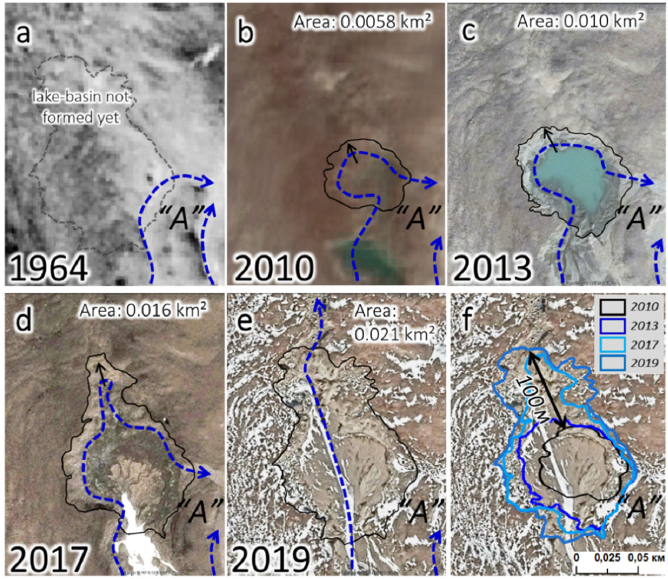
Figure 7. The Toguz-Bulak lake basin, 1964–2019. ( a ) Image from Corona KH-4A on 6 October 1964. ( b ) Advanced Land Observing Satellite/Panchromatic Remote-sensing Instrument for Stereo Mapping (ALOS/PRISM) image in 2010. ( c – e ) Images from Google Earth (World View), 2013–2019. ( f ) Boundaries of the lake basin during 2010–2019 (background image from Google Earth (World View), 2019). The dashed blue lines show the direction of meltwater flow.